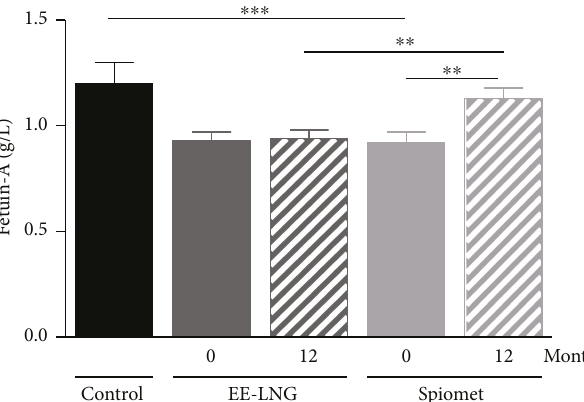
Figure 1: Longitudinal fetuin-A concentrations (mean ± SEM) in adolescent girls with polycystic ovary syndrome who were randomized to receive either an oral contraceptive [ethinylestradiol-levonorgestrel (EE-LNG) n = 18 ] or low-dose spironolactone (50 mg/d), pioglitazone (7.5 mg/d) plus metformin (850mg/d) (SPIOMET, n = 17 ), for 12 months. Control girls ( n = 25 ) matched for age and body mass index were assessed for comparison. ∗∗∗ P < 0 001 for baseline di ff erences between patients and controls; ∗∗ P < 0 01 within patient subgroups for 0 to 12 months and between groups at 12